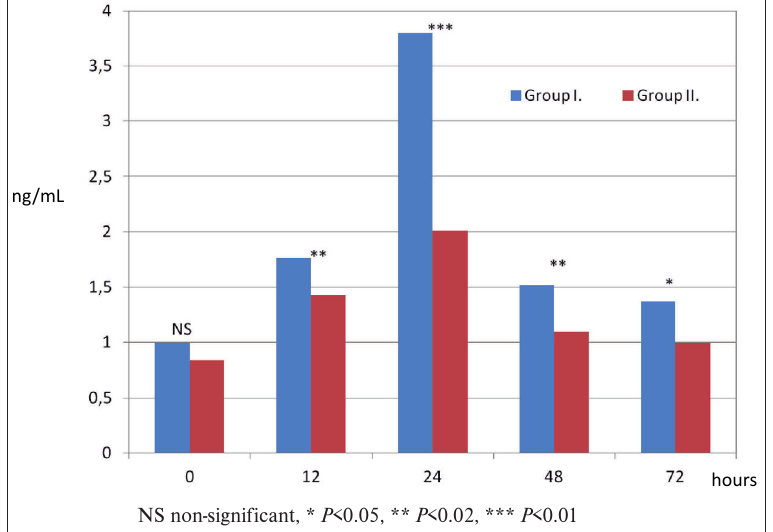
Fig. 1. Serum visfatin before and after surgery in Group I and Group II (mean